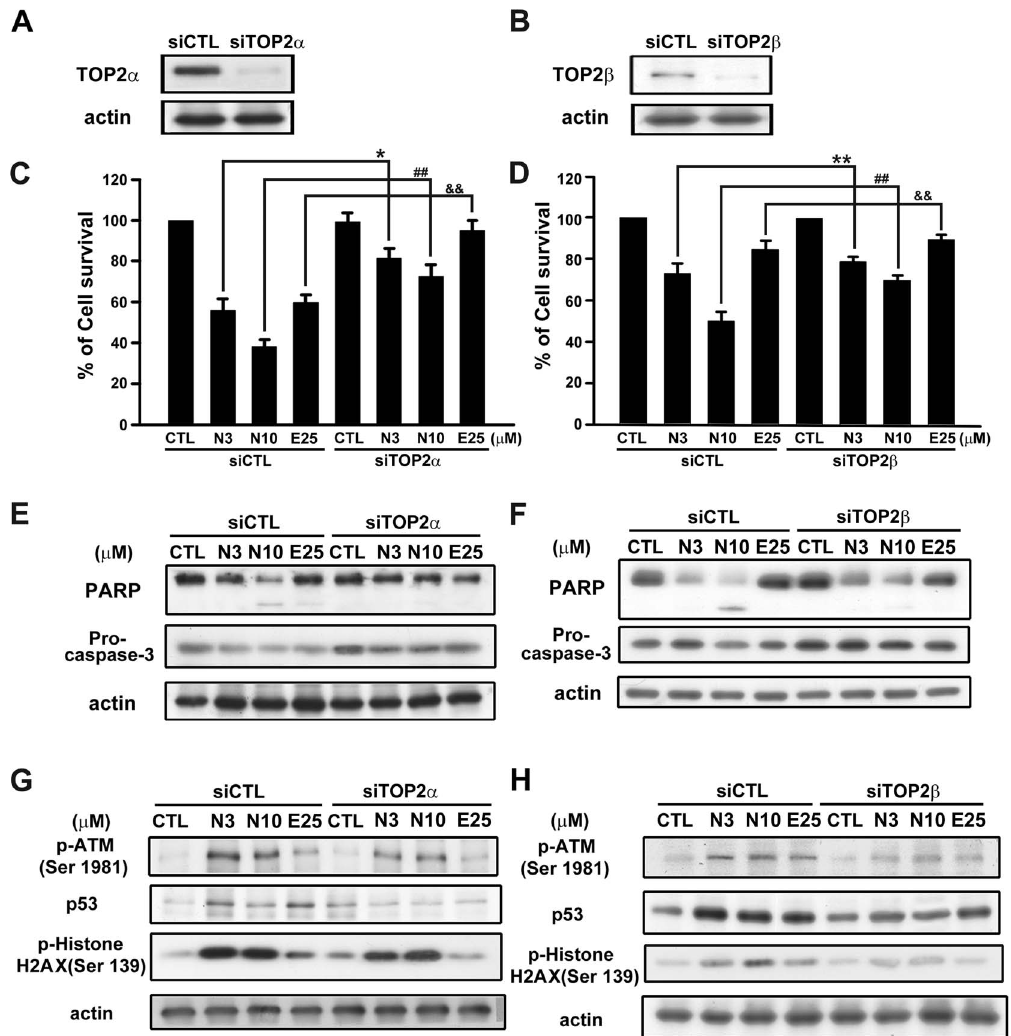
Figure 7. Effects of TOP2 in NPRL-Z-1-induced cell death and DNA damage signaling. TOP2 a or TOP2 b siRNA was transfected to evaluate expression of TOP2 a (A) and TOP2 b (B), cell viability using the MTT assay (C and D), expression of apoptosis-related proteins (PARP and pro-caspase-3) (E and F) for 24 h, and DNA damage-related proteins (p-ATM, p53, and p-histone H2AX) (G and H) for 1 h in A498 cells. Data are expressed as the mean percentage of control 6 S.D. of three independent experiments. * , & p , 0.05, and ** , ## , && p , 0.01 compared with the treatment group. N3, N10 and E25 indicated as NPRL-Z-1 3 m M, 10 m M and etoposide 25 m M, respectively.